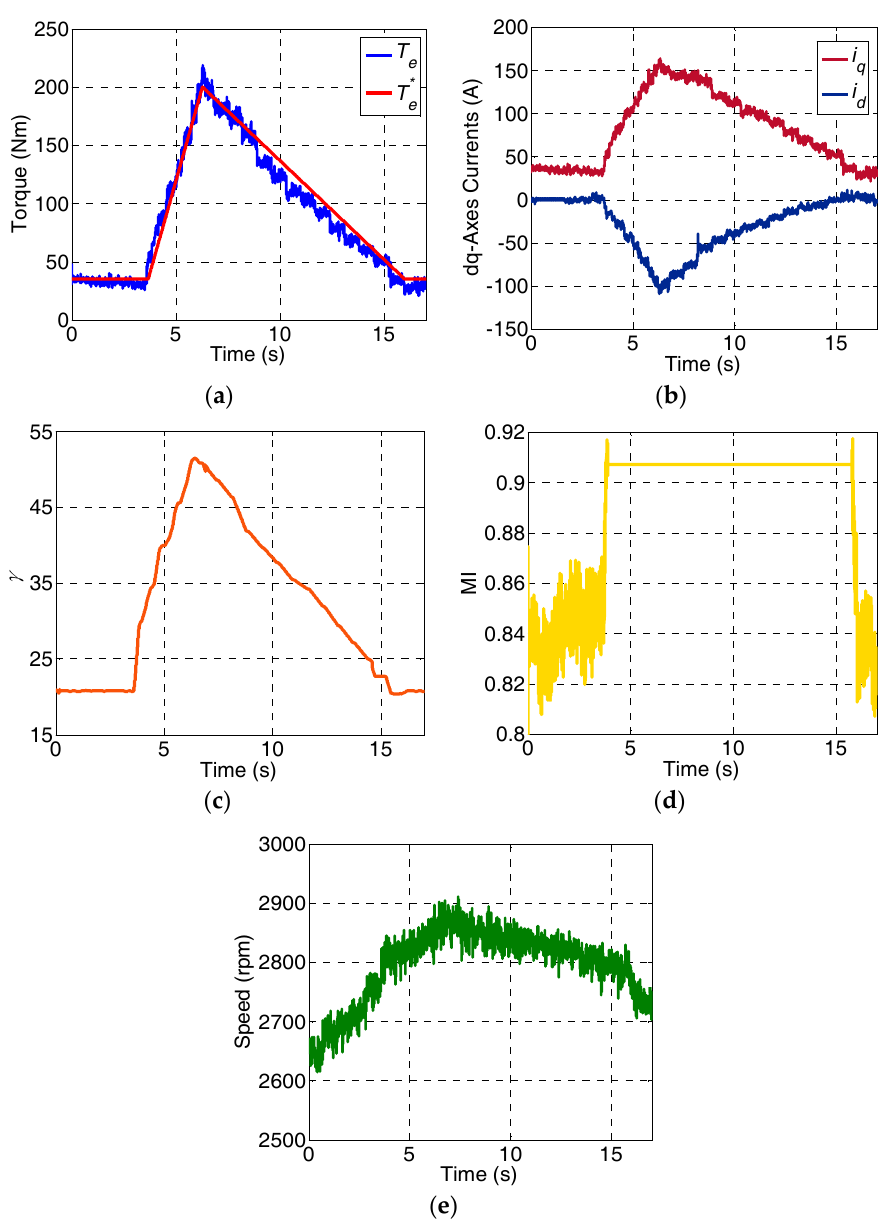
Figure 10. The experiment results that the transition of interior permanent magnetic synchronous motor between the constant torque and FW region with the output torque changing. ( a ) Torque; ( b ) dq-Axes Currents; ( c ) γ ; ( d ) MI; ( e ) Speed.